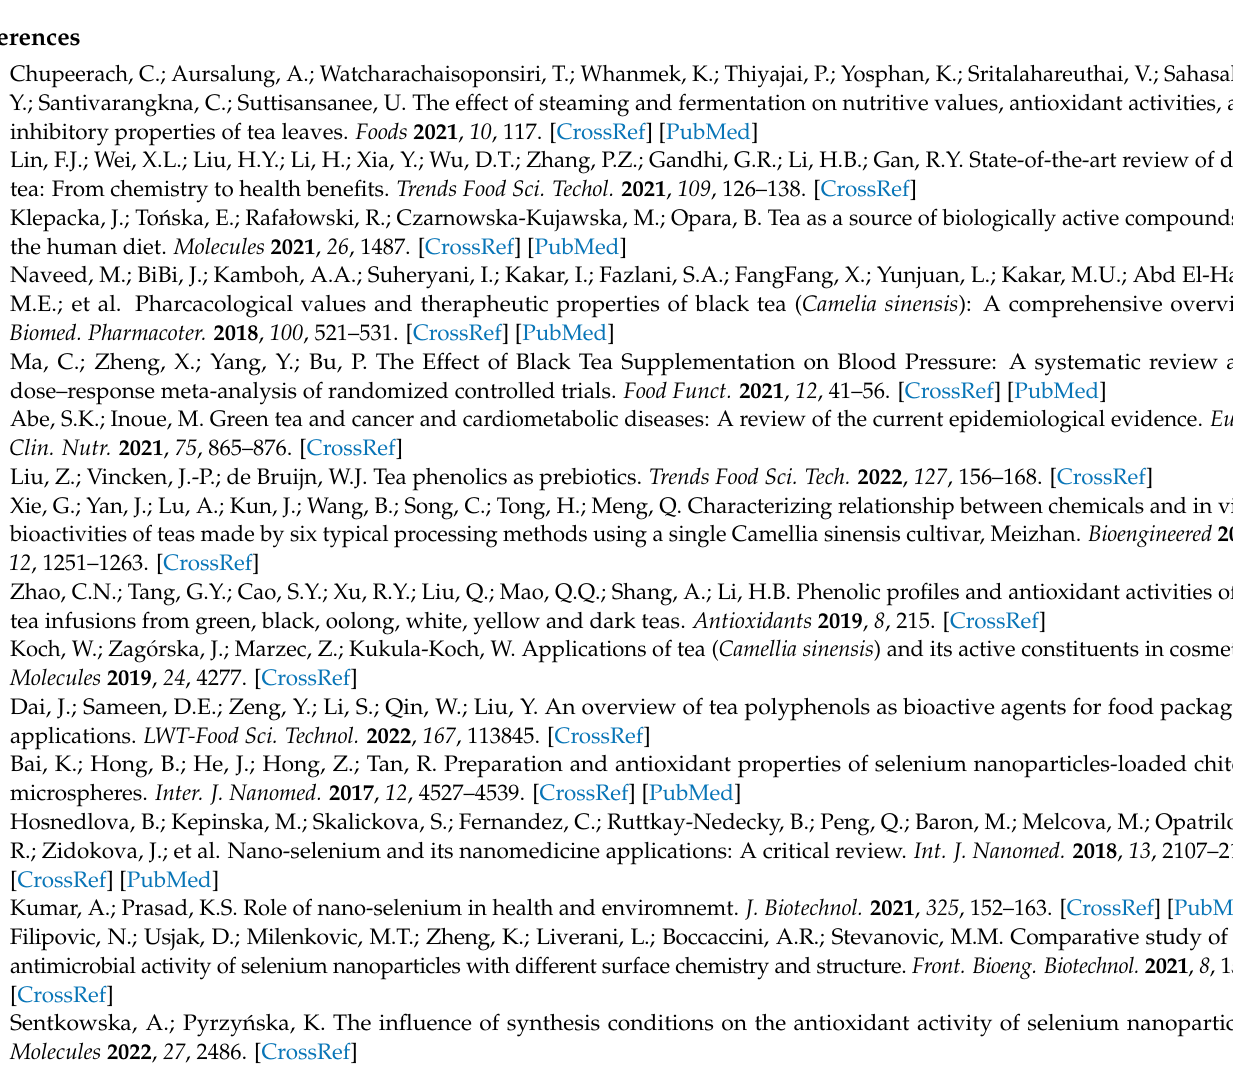
SeNPs; Figure S2: Particle size distribution in GSeNPs obtained by DLS method; Figure S3: 48 h stability of an average diameter of obtained SeNPs.; Figure S4: EDS spectra of BSeNPs. GSeNPs, RSeNPs and WSeNPs.; Table S1: The concentrations of polyphenolic compounds in postreaction mixture (in mg L − 1